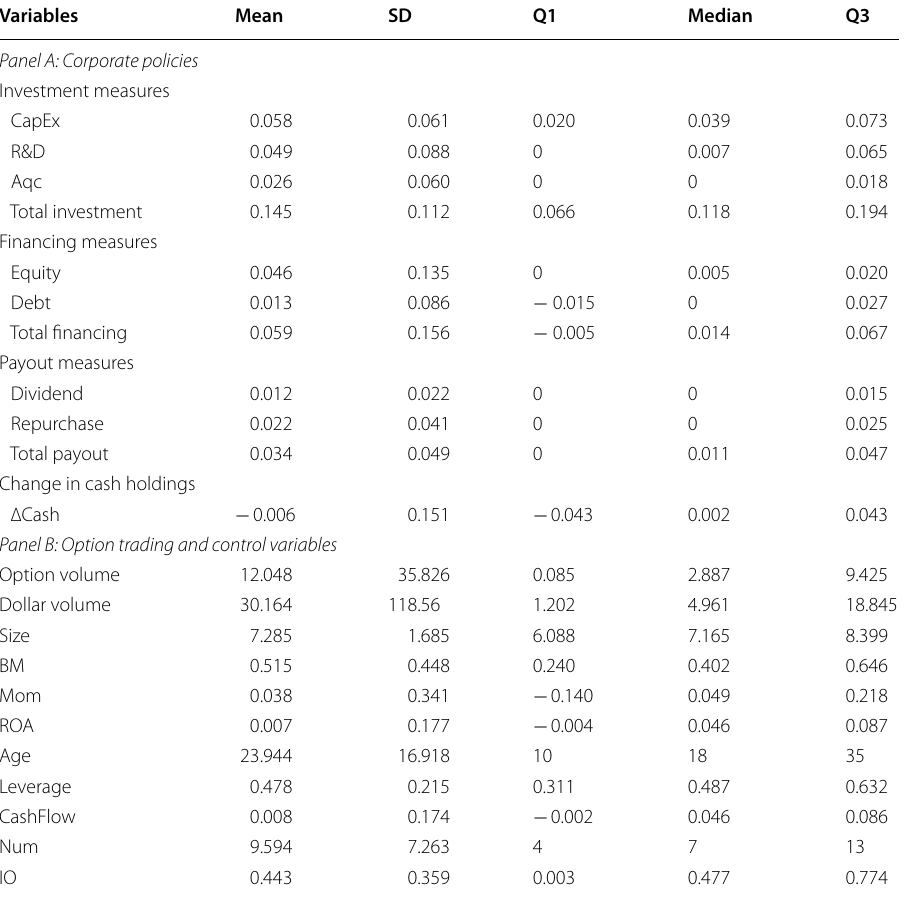
Table 1 Summary statistics of firm